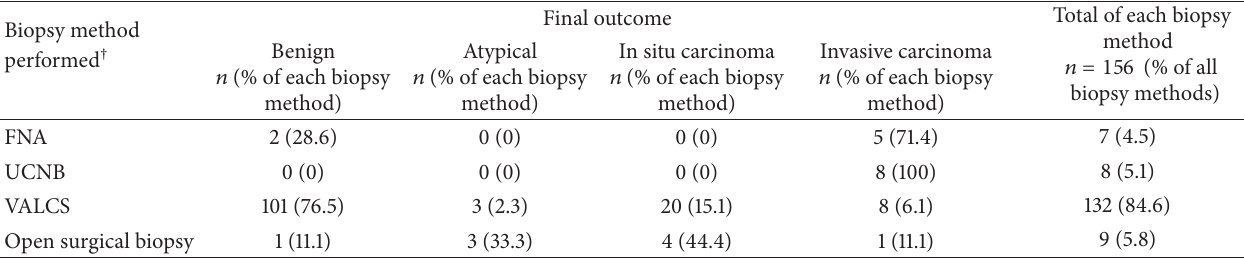
Table 2: Distribution of biopsy investigations conducted with final client outcome ∗ . Biopsy method